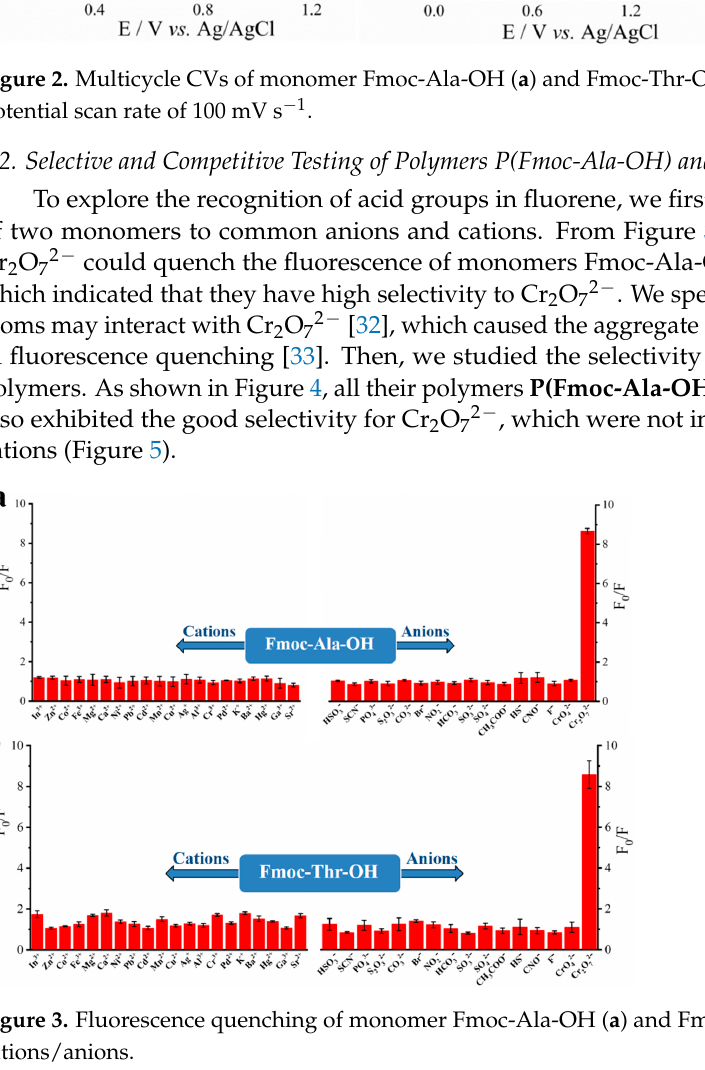
Figure 2. Multicycle CVs of monomer Fmoc-Ala-OH ( a ) and Fmoc-Thr-OH ( b ) in the BFEE system. Potential scan rate of 100 mV s − 1 .